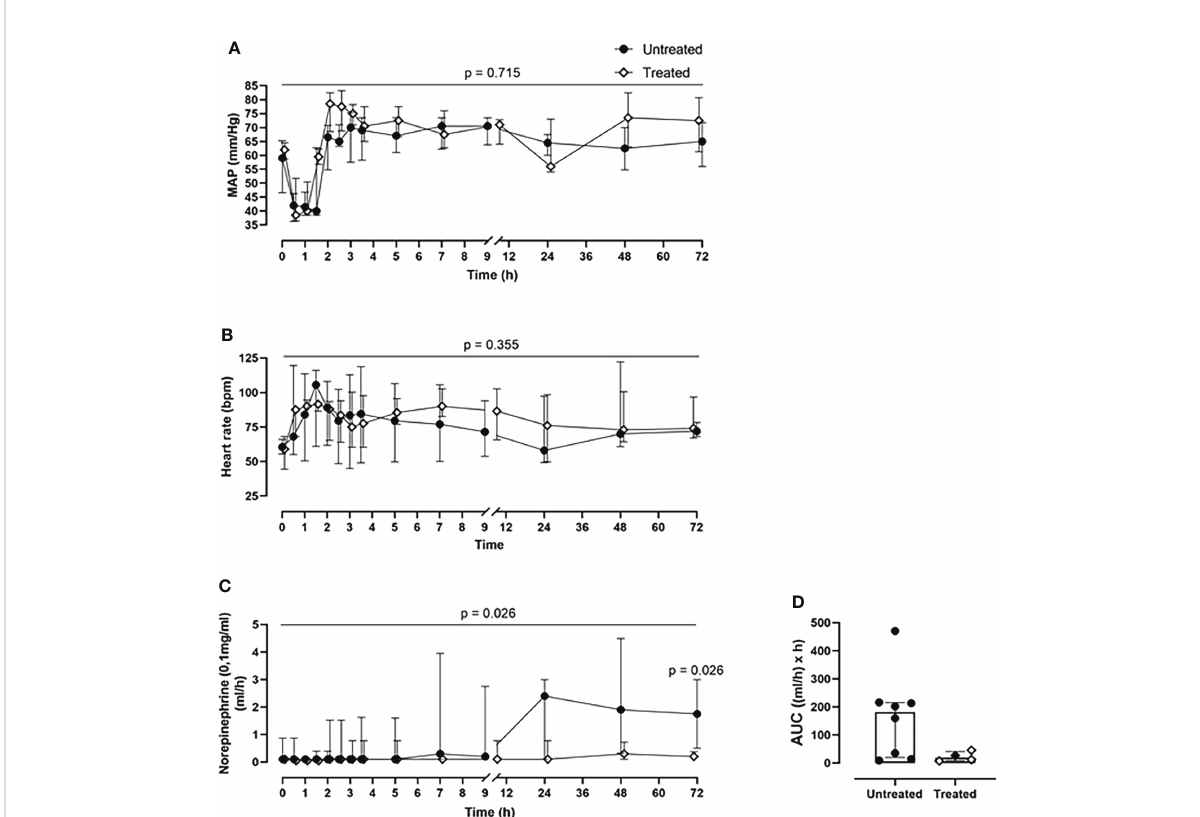
FIGURE 2 Cardiovascular monitoring. (A) MAP and (B) heart rate monitoring. (C) Norepinephrine dosing monitoring and the corresponding (D) AUC analysis revealed that the treated group (n=4) required less norepinephrine for maintaining the MAP ≥ 60mmHg, compared to the untreated group (n=8). Overall p-value for group comparison of treated vs. untreated animals over time is displayed above the summary trajectories. In the AUC graphical representation, the fi rst pig, receiving lower inhibitor dosage, is represented as black fi lled diamond.